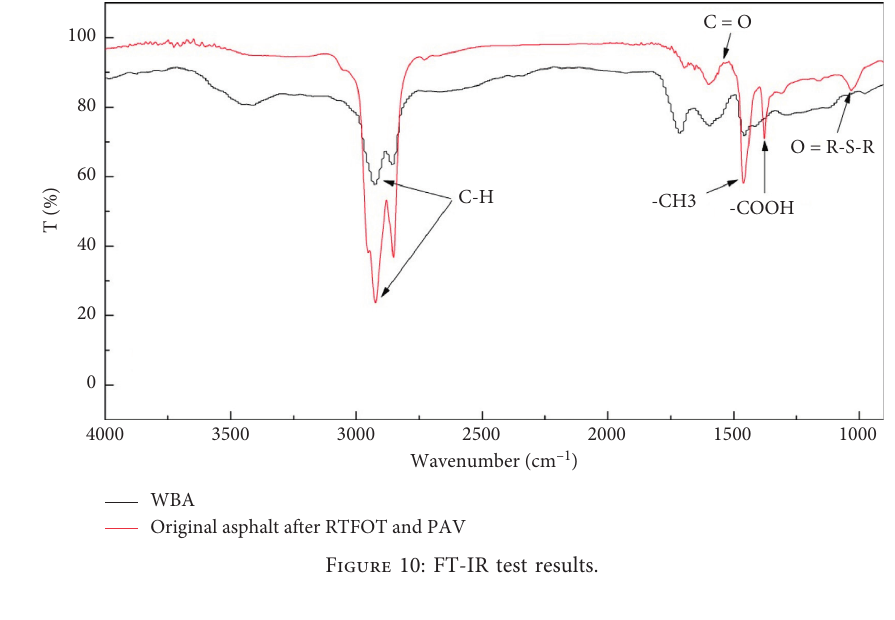
Figure 10: FT-IR test results.